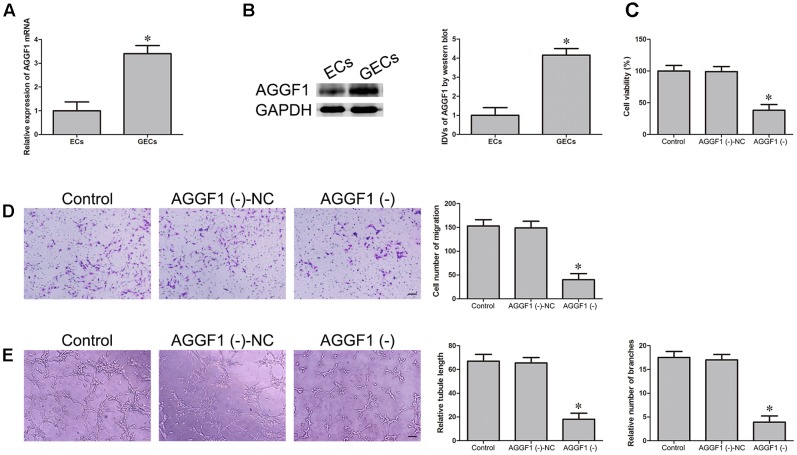
AGGF1 mRNA expression in GECs and inhibition of AGGF1 knockdown on proliferation, migration, and tube formation of GECs. (A) Relative AGGF1 mRNA expression in ECs and GECs by quantitative real-time PCR. (B) Relative AGGF1 expression in ECs and GECs by Western blot assay. Data are presented as mean ± SD. (n = 5, each group), ∗P < 0.01 vs. ECs group. (C) CCK-8 assay was conducted to evaluate the effect of AGGF1 knockdown on GECs proliferation. (D) Effect of AGGF1 knockdown on quantification number of GECs migration. (E) Effect of AGGF1 knockdown on GECs tube formation. Data are presented as mean ± SD. (n = 5, each group), ∗P < 0.05 vs. AGGF1 (-)-NC group. Scale bars represent 30 μm.